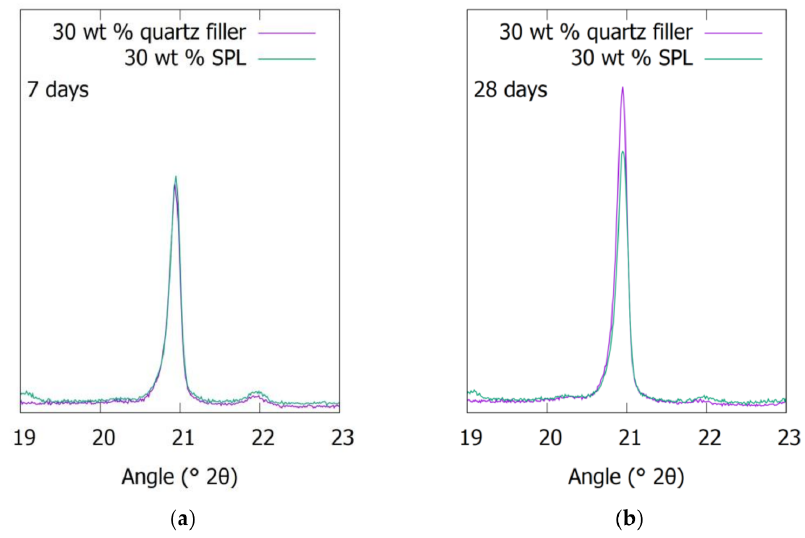
Figure 7. Detailed image of the Portlandite peak in the X-ray diffractograms of hydrated pastes including 30 wt% of quartz filler and 30 wt% of spent pot lining aluminosilicates at ( a ) 7 and ( b ) 28 days.